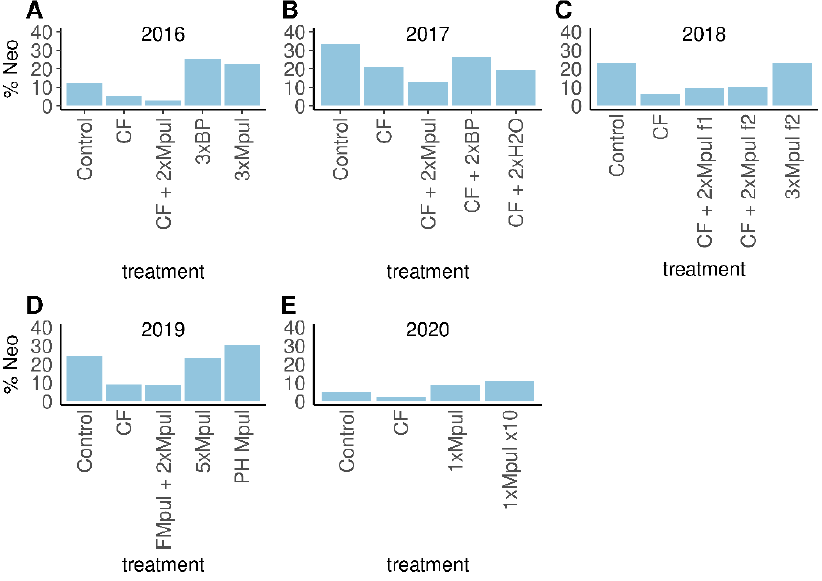
Figure 7. Field application of M. pulcherrima following fungicide treatments reduces Neofabraea rot in stored apples in some years. Field trials with M. pulcherrima have been carried out since 2016 in an experimental orchard in Switzerland. The percentage of apples (based on weight of the total harvest of all four replicates) with signs of Neofabraea rot is shown for each year from 2016 to 2020 (panels A – E ). Treatments were compared to an untreated control and an integrated pest management control comprised of one Captan (captan) 0.125% and Flint (trifloxystrobin) 0.015% (CF) application 21 days before harvest. Yeast and control treatments (H 2 O) were either applied twice (10–14 and 3 days prior to harvest) after a prior CF treatment or three times if no CF treatment was used (21, 10–14, and 3 days before harvest). The treatments included M. pulcherrima (Mpul) or, for comparison, the commercially available product BlossomProtect TM (BP). In 2018, the Mpul treatment was applied as formulation 1 (f1) or as formulation 2 (f2). In 2019, the first Mpul treatment was applied premixed with a reduced amount of fungicide (FMpul) and as a postharvest treatment (PH Mpul). In 2020, one treatment consisted of a 10× Mpul concentration.